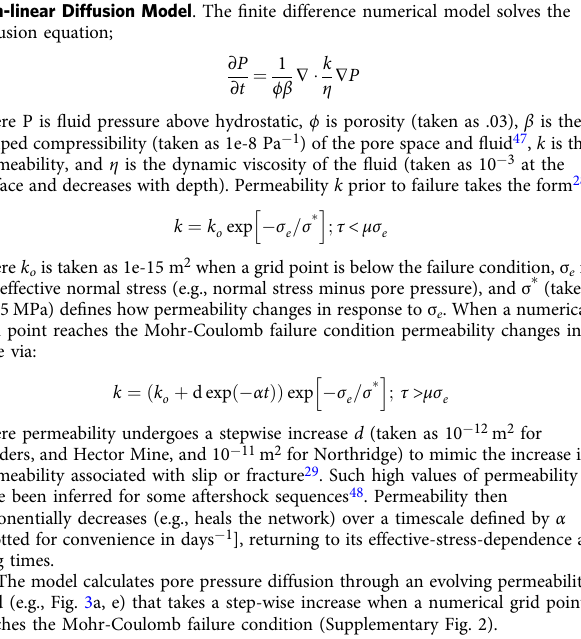
Fig. 7 Synthesis of modeling results. Data reveals an exponential relationship (95% con fi dence. bounds) between the Omori-Utsu p-value and the timescale of permeability recovery. Inset shows all of the time- histories modeled in this study (see Fig. 1 for names of datasets), and shows that the shape of the curve is a measure of the permeability recovery time ( α distribution of hypocenters in the x-z plane always looks roughly the same, the model results always look the same, and the only difference between each sequence is the temporal decay of aftershocks, which in the model is controlled by α . A compendium of calculated pressure and permeability histories (Supplementary Fig. 7) quanti fi es permeability and pressure evolution for each of the simulations presented for comparison between all simulations.